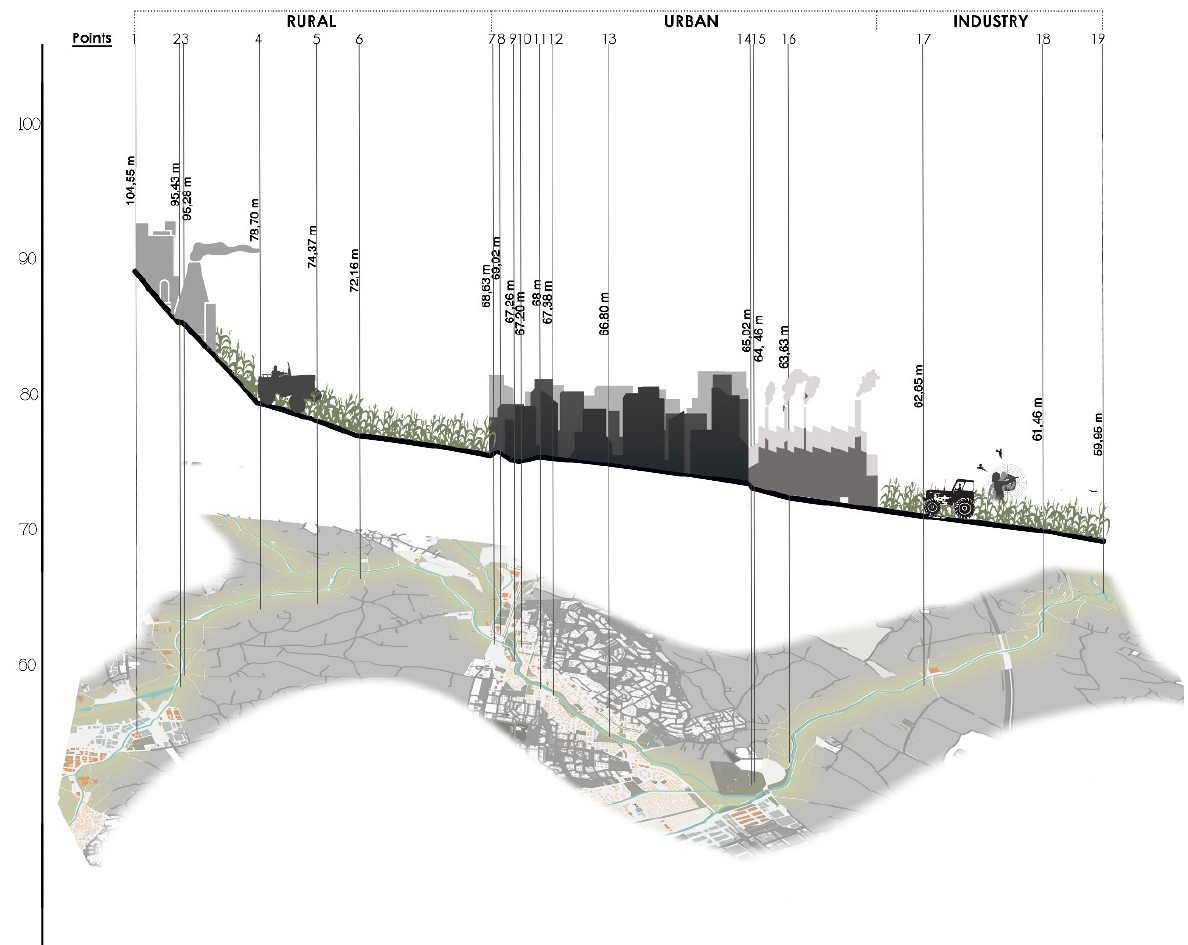
Figure 2. Three zones along with the green and blue infrastructure.